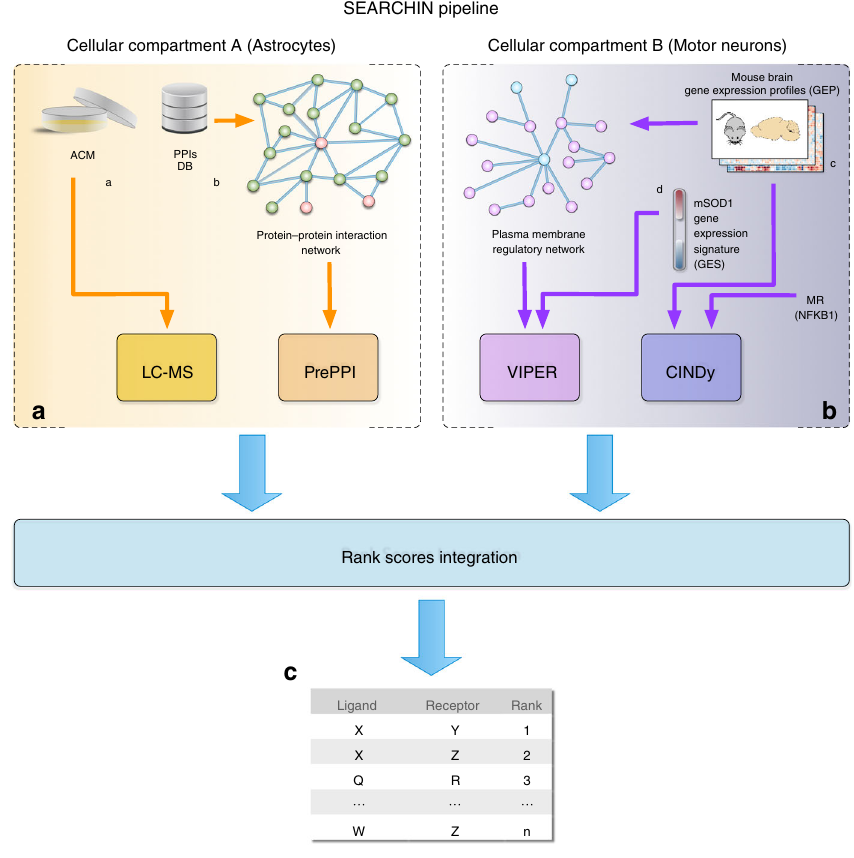
Fig. 2 Conceptual work fl ow of the SEARCHIN pipeline. a Cellular compartment A (ACM from astrocytes) was analyzed using inputs: (I) list of candidate ligands enriched in the Astrocyte Condition Media (ACM) and (II) Protein-protein interactions (PPIs) interactome, both derived as explained in the Methods Section. b Cellular compartment B (MNs) was compiled using inputs: (III) set of gene expression pro fi les (GEP) from tissue type relative to cellular compartment B, for both, generation of a transcriptional regulatory interactome and modulator analysis and (IV) gene expression signature (GES) generated as differential between presence and absence of ligand signals. c The SEARCHIN pipeline produces a list of inferred ligand – receptor interactions prioritized based on the evidences assessed in a , b . Please see Methods section for detailed description. See also Table 1 and Supplementary Tables 1 – 4. Source data provided as source data fi